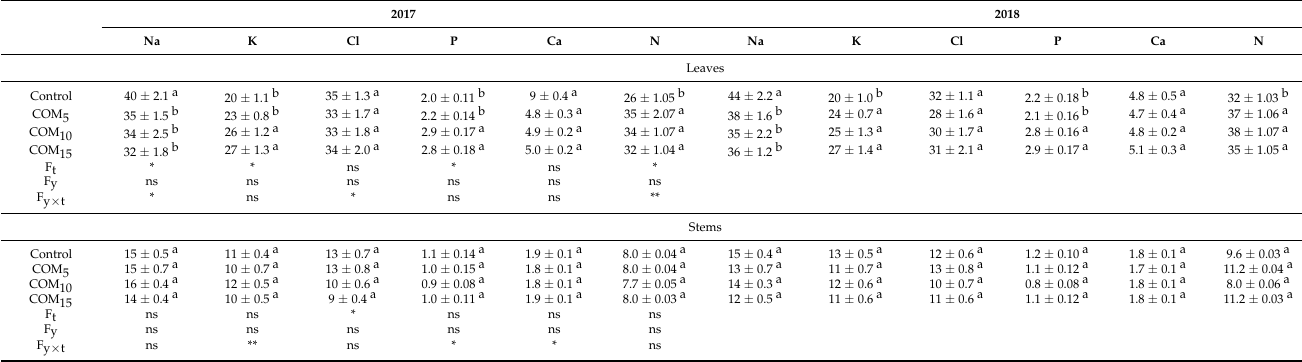
Table 3. Effect of compost treatments on the mineral content of leaves and stems of river saltbush plants (g kg − 1 ).